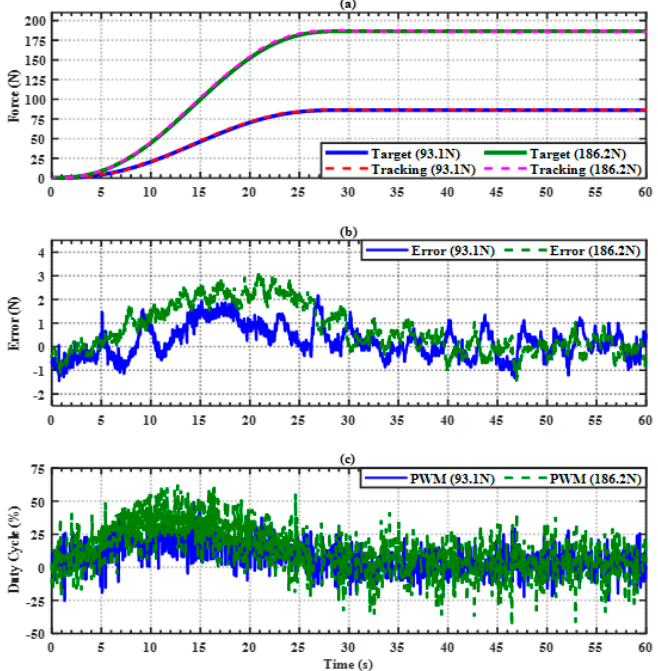
Figure 7. Static bodyweight unloading force control of ILESO − PSMC, 20% (93.1 N) and 40% (182.6 N) of female subject body weight (465.5 N). ( a ) Unloading force tracking response; ( b ) unloading force tracking error; ( c ) duty cycle of PWM.